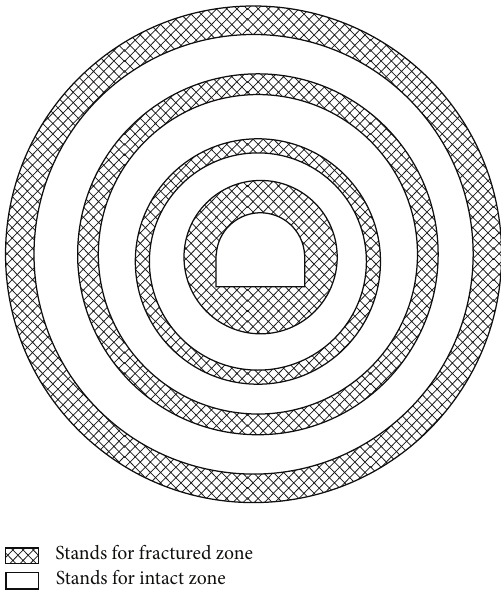
Figure 1: Sketch of the zonal disintegration phenomena in deep